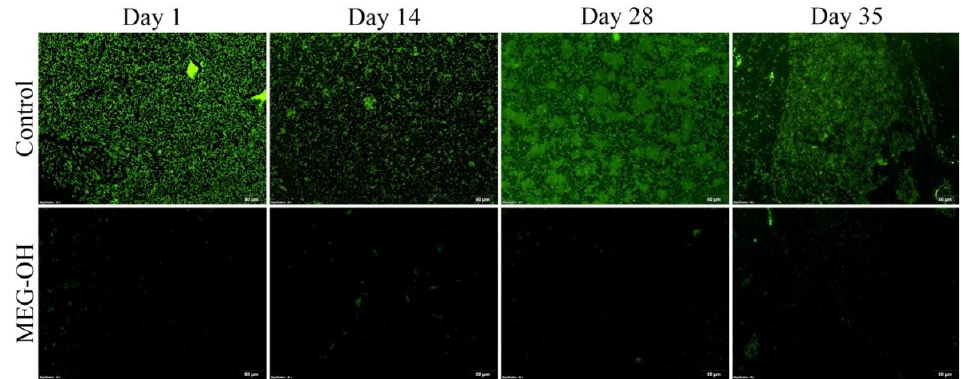
Figure 3. Fluorescence images of control, and MEG-OH coated surfaces that were exposed to static LB containing E. coli for 1 day, then at days 14, 28, and 35 under flow of 2 g/L concentration LB